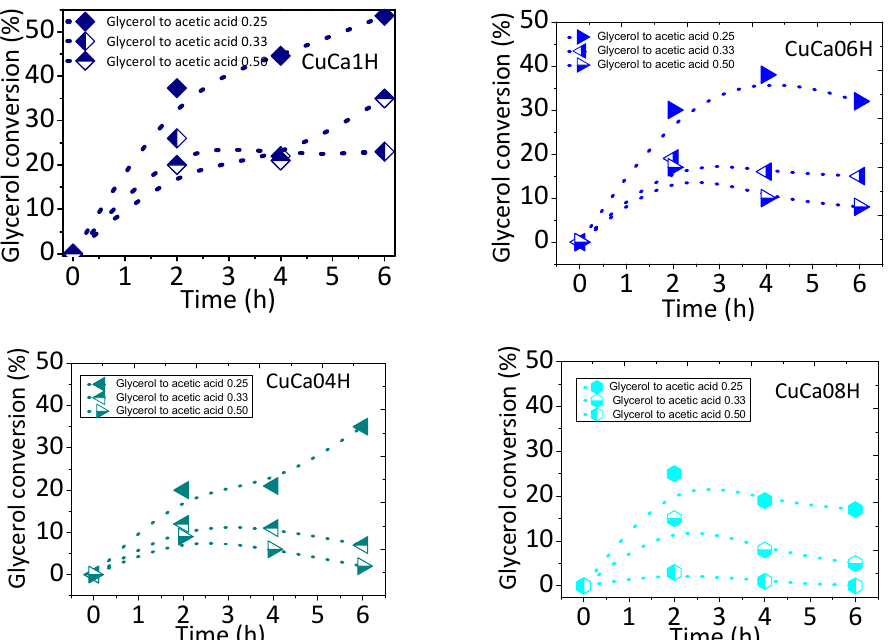
Figure 5. Evolution of glycerol conversion as a function of the reaction time using different glycerol to acetic acid molar ratios over the most active catalysts in the EG reaction. Reaction conditions: 75 mg of catalyst and glycerol to acetic acid molar ratios varying from 0.25 to 0.50. The reaction temperature was kept at 80 °C.